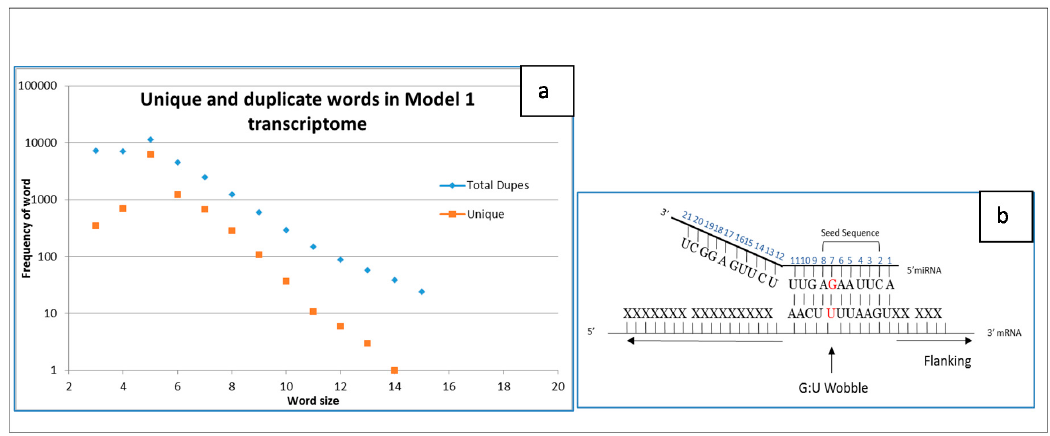
Figure 1. ( a ) Measures of number of unique and duplicate words in Simple Model transcriptome for various word size; ( b ) Correspondence to size of seed sequence for miRNAs. Red base pair is an allowed non-canonical matching.